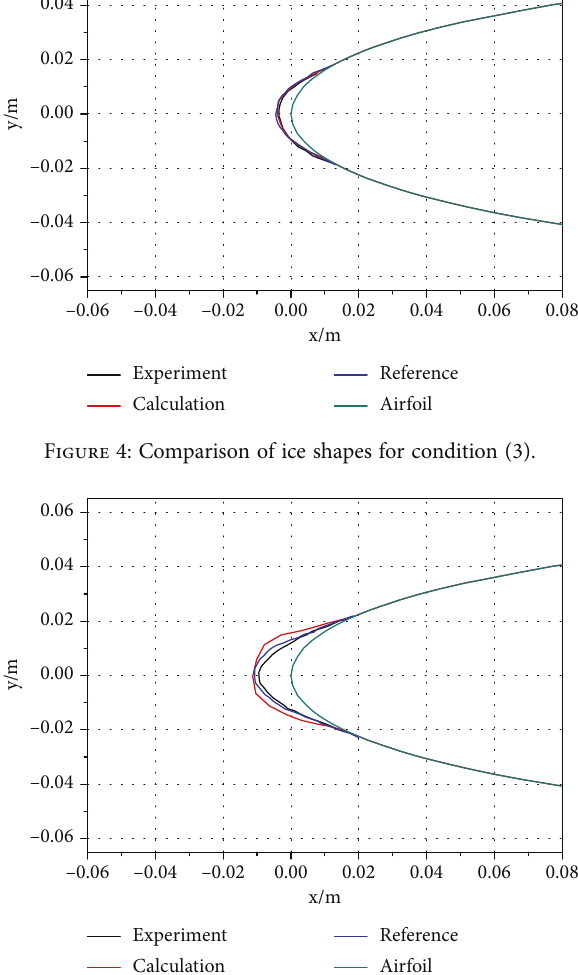
Figure 3: Comparison of ice shapes for condition (2).